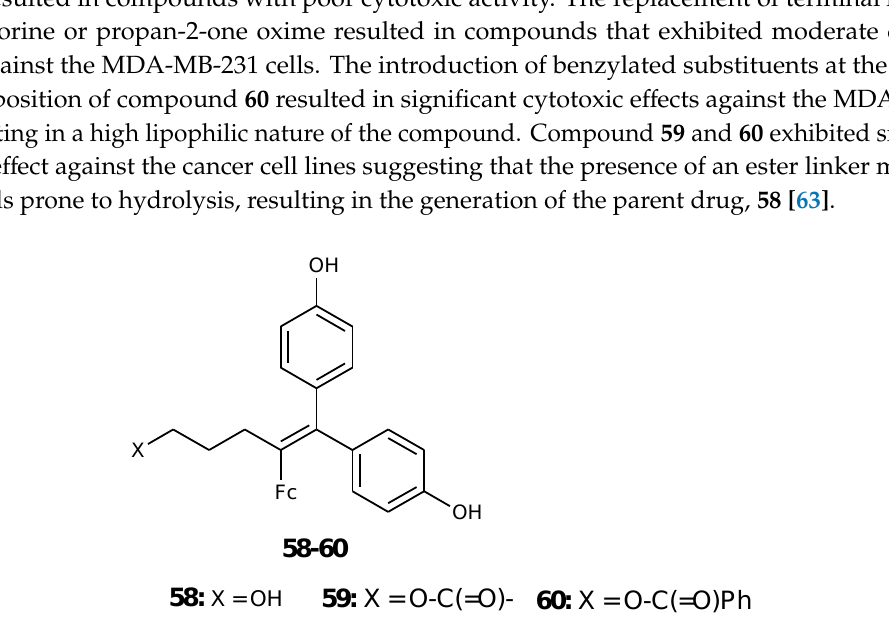
Figure 20. Chemical structures of hydroxypropyl-ferrocephenol derivatives ( 58 – 60 ).